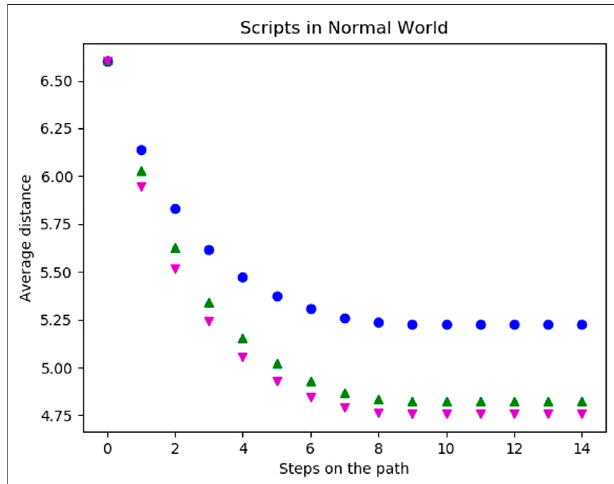
FIGURE 7 | Average distance ( V g ) of the possible goal states per step on the trajectory for all scripts of length two in blue ( C ), all scripts of length three in magenta ( ▼ ) and the scripts of length two when removing all scripts only oscillating between two states in green ( ▲ ).